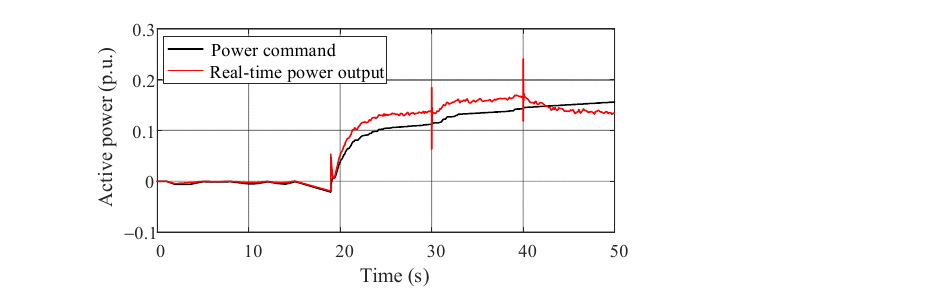
Figure 27. The output power of LIB and SC in case II. ( a ) Output power of LIB. ( b ) Output power of SC .